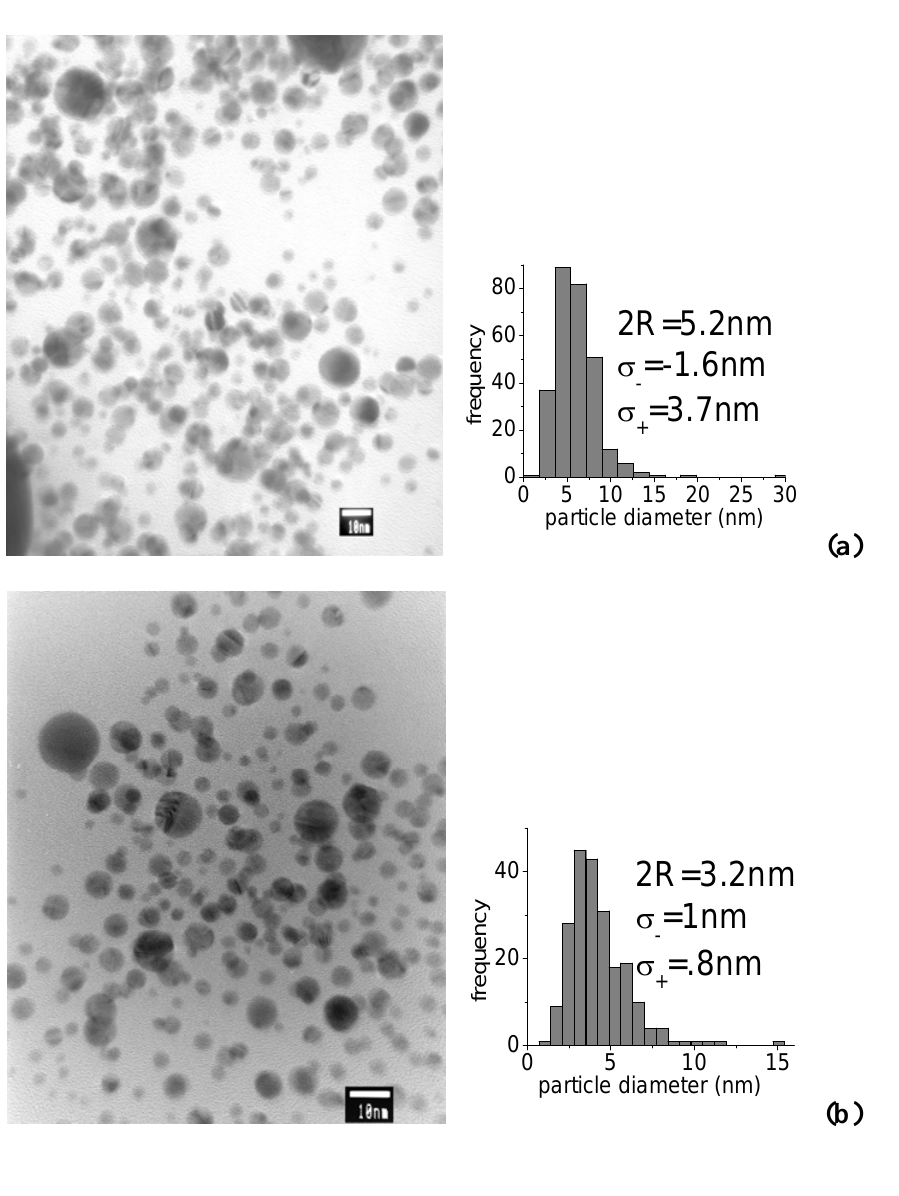
Figure 2. TEM images and statistical distribution of particle size for the samples of Figure 1: (a) 1,064 nm, 5m J, 16 min; (b) 532 nm, 5m J, 16 min; (c) 355 nm , 5m J, 16